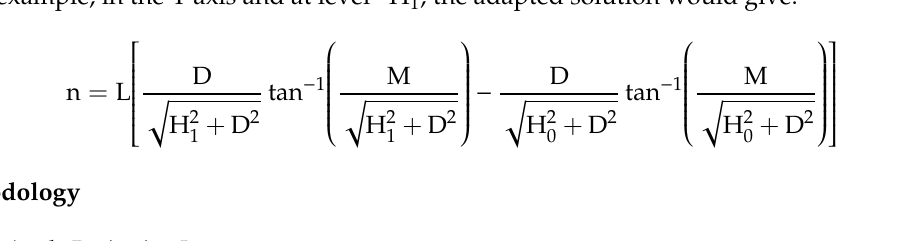
Figure 4. Outline of a ‘typical’ rectangle to be used for the calculations.